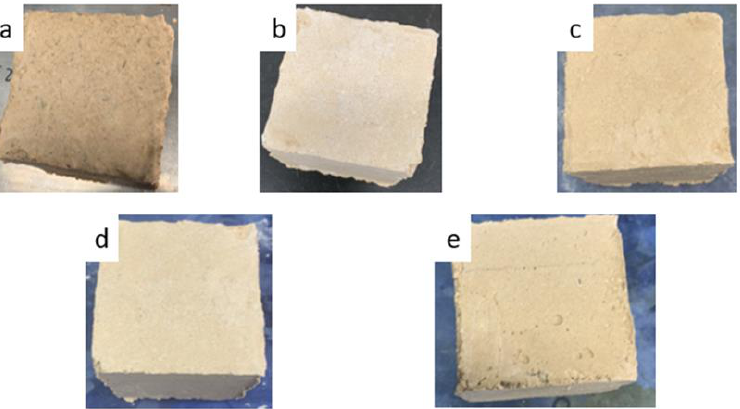
Figure 14. MKPCs with the optimum compositions ( a ) before and after ( b ) 1, ( c ) 5, ( d ) 10, and ( e ) 15 times freeze-thaw cycles.